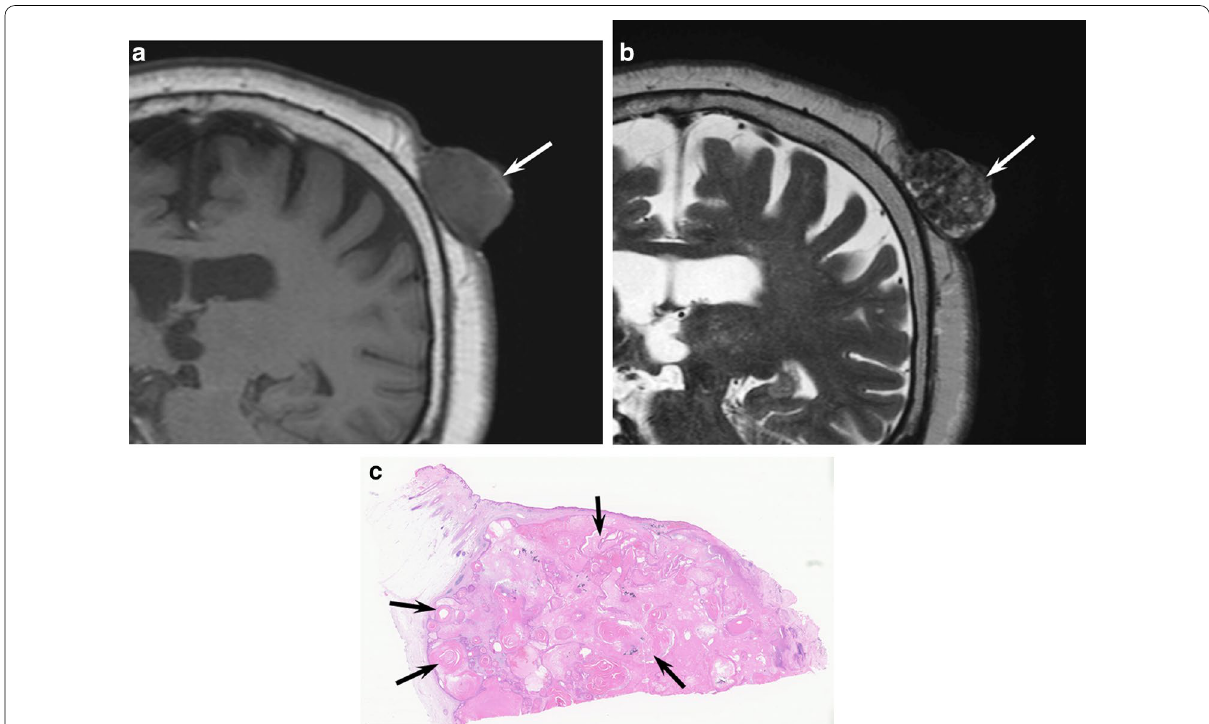
Fig. 8 A 81‑year‑old female with a proliferating trichilemmal tumor on the scalp. a Oblique sagittal T1‑weighted image showing an elevated mass with nonspecific signal intensity (arrow). b Oblique sagittal T2‑weighted image showing heterogeneous hypointensity (arrow). c Histological specimen (H&E stain; scale bar, 5 mm) showing a well‑circumscribed mass with multiple keratinization